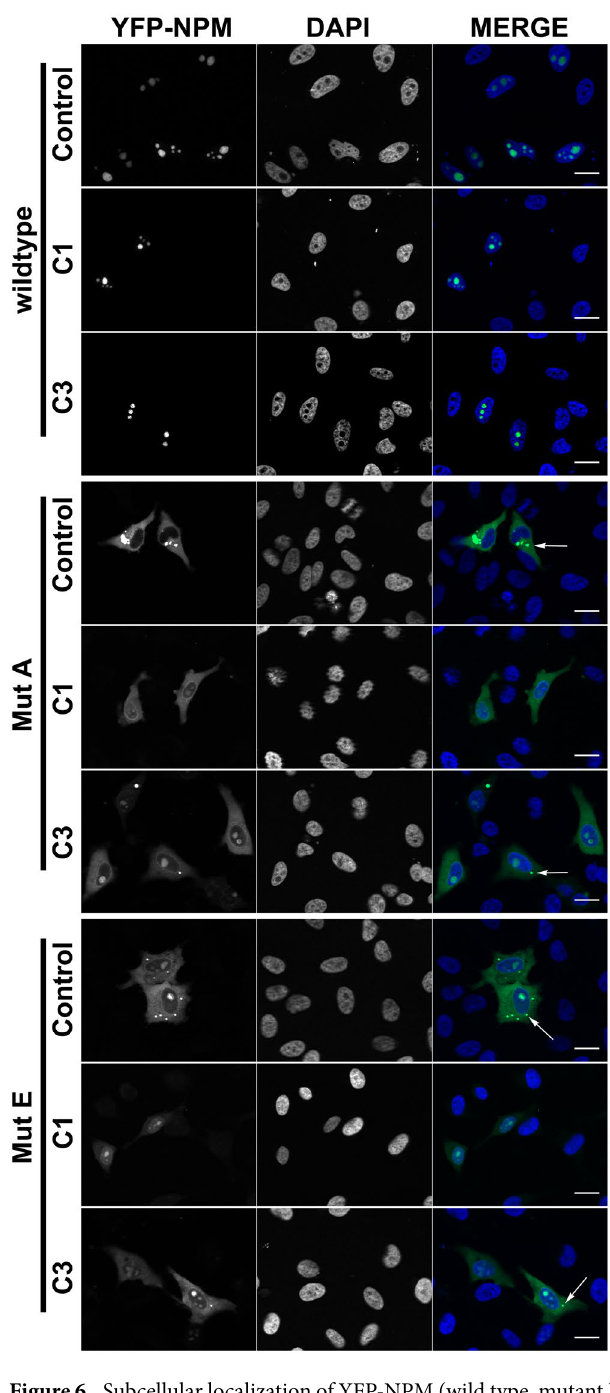
Figure 6. Subcellular localization of YFP-NPM (wild type, mutant E or mutant A) in examples of untreated HeLa cells or treated with compounds C1 and C3. Confocal microscopy images of HeLa cells in the absence or presence of 50 μ M C1 or C3. YFP fluorescence is shown in green and DNA, stained with DAPI, in blue. Bright green fluorescence dots in the cytoplasm of cells transfected with the mutants are assigned to protein aggregates (arrows, see